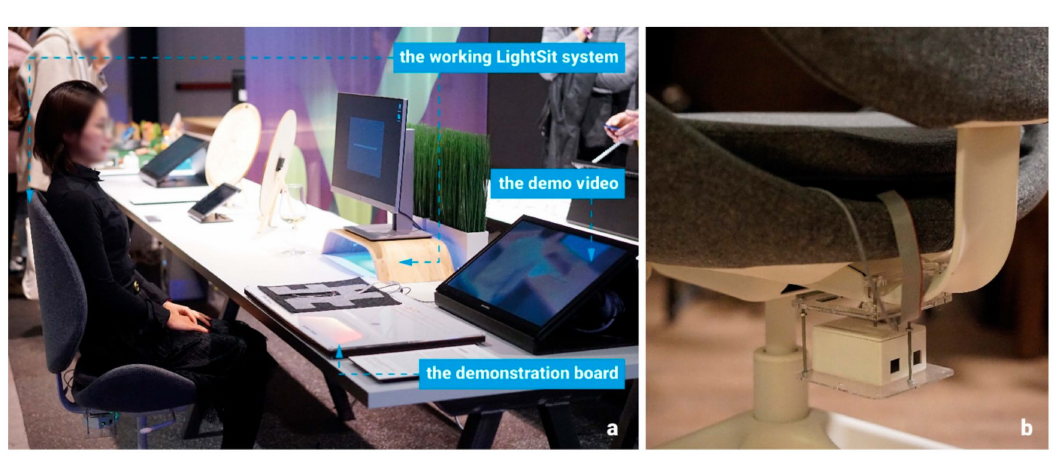
Figure 9. The setup of the exhibition at Dutch Design Week (DDW)